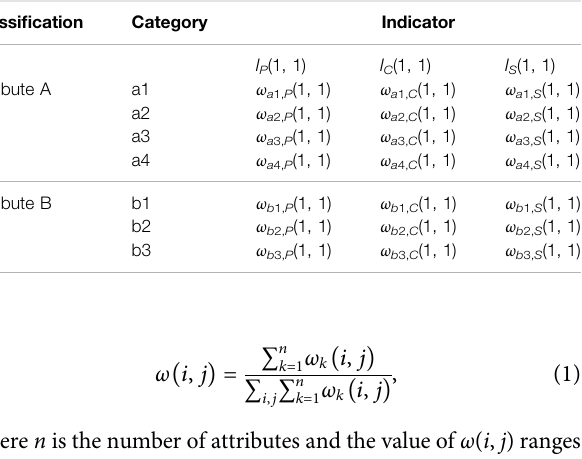
TABLE 2 | Individuation weight for different